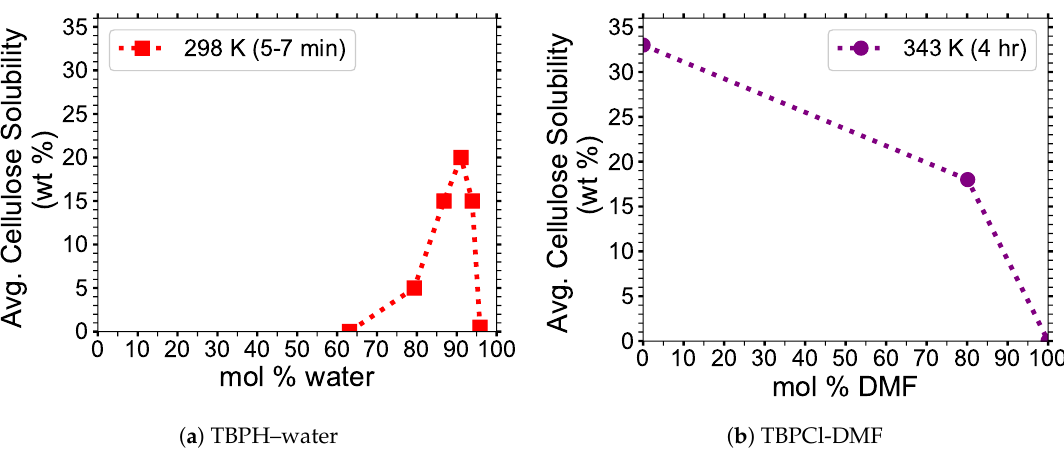
Figure 1. The experimental cellulose solubility in the tetrabutylphosphonium hydroxide (TBPH)–water and tetrabutylphosphonium chloride-dimethylformamide (TBPCl-DMF) solutions: ( a ) TBPH–water solution at 298K and 1atm (Data from Abe et al.) [2]; ( b ) TBPCl-DMF solution at 343K and 1atm (Data from Burns et al.)